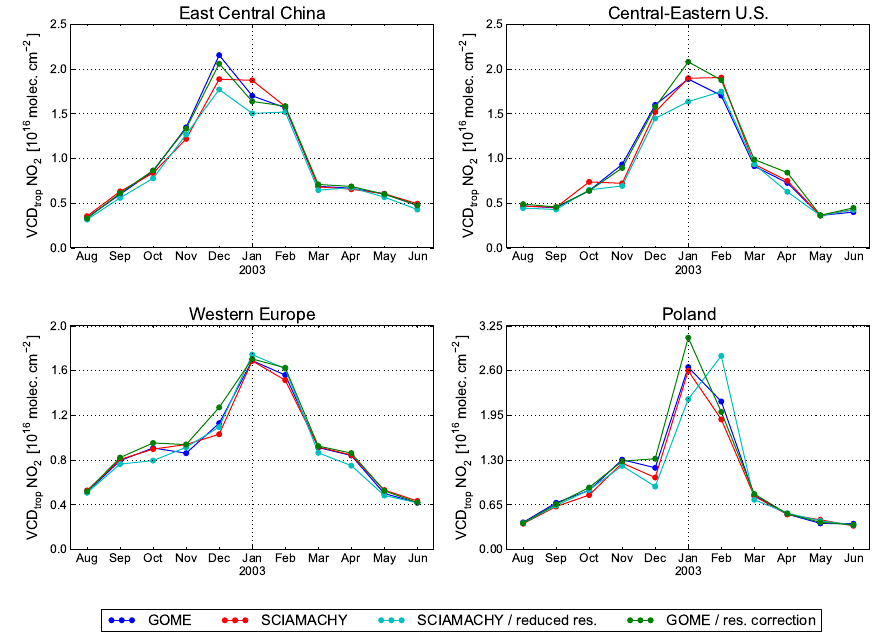
Fig. 10. Monthly averages of VCD trop NO 2 over four country- to continental-scale areas, for the time period August 2002–June 2003. The regions are the same as used in Richter et al. (2005). Only those days for which both GOME and SCIAMACHY measurements for a city are available are taken into account.